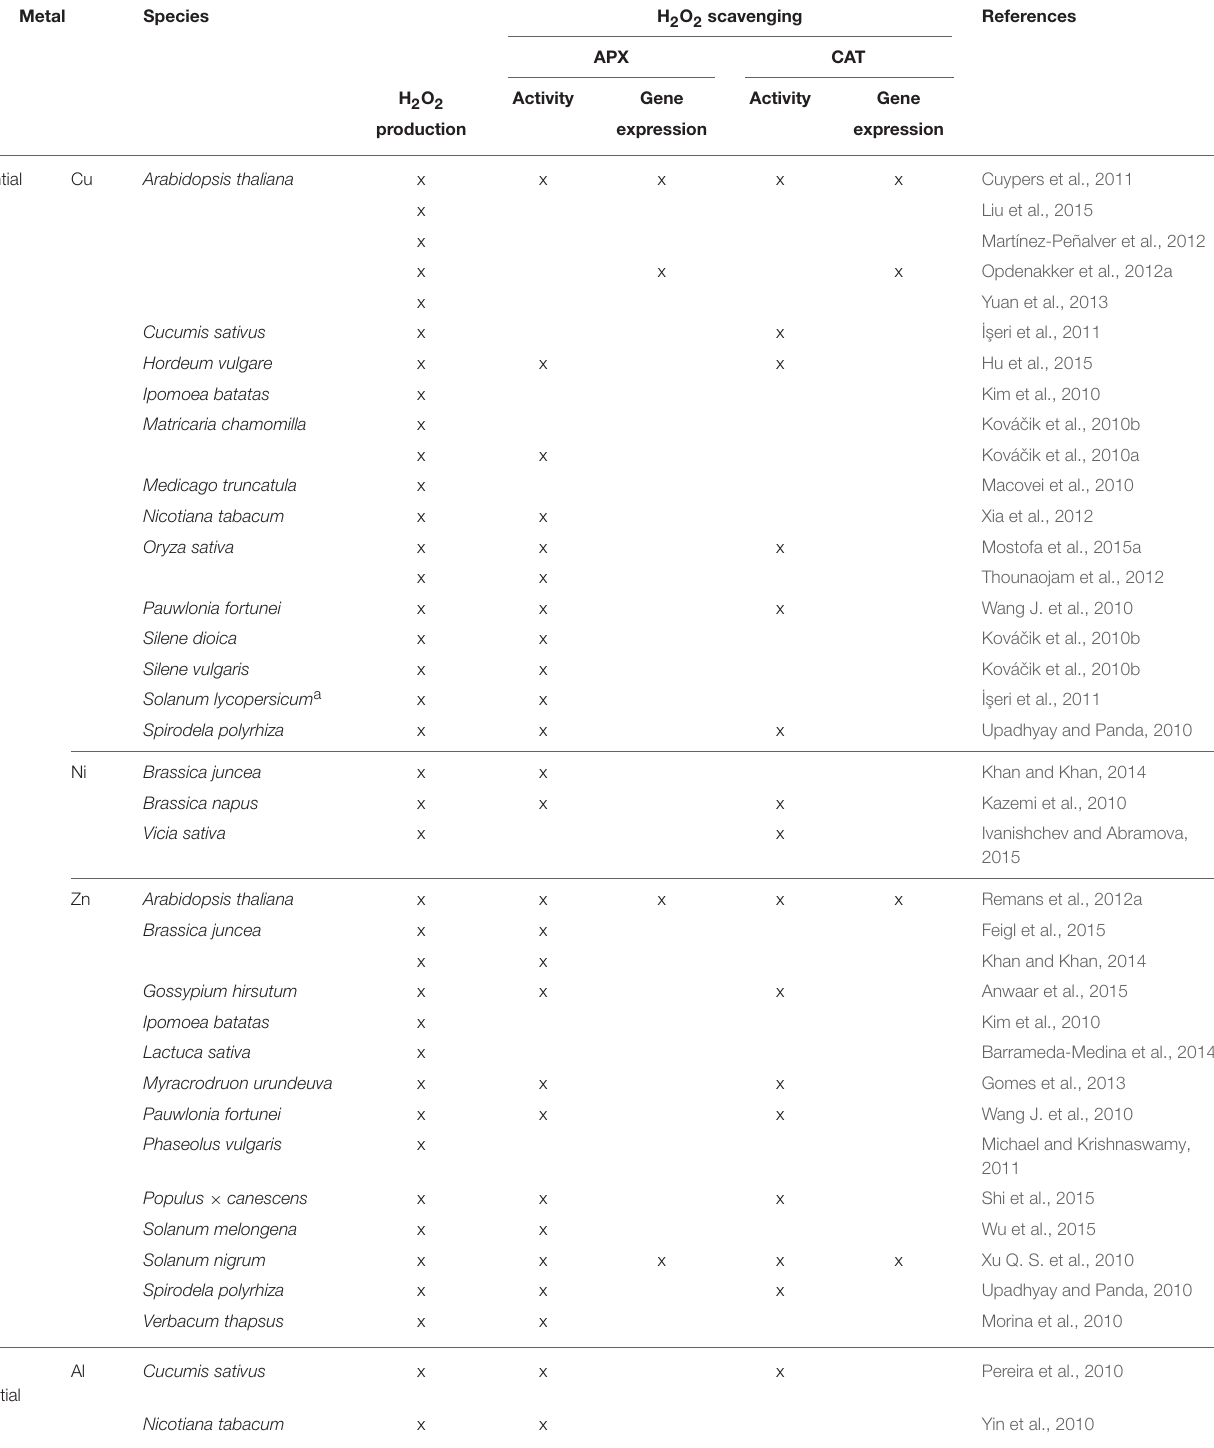
TABLE 1 | Metal-induced H 2 O 2 production and scavenging in plants. Metal